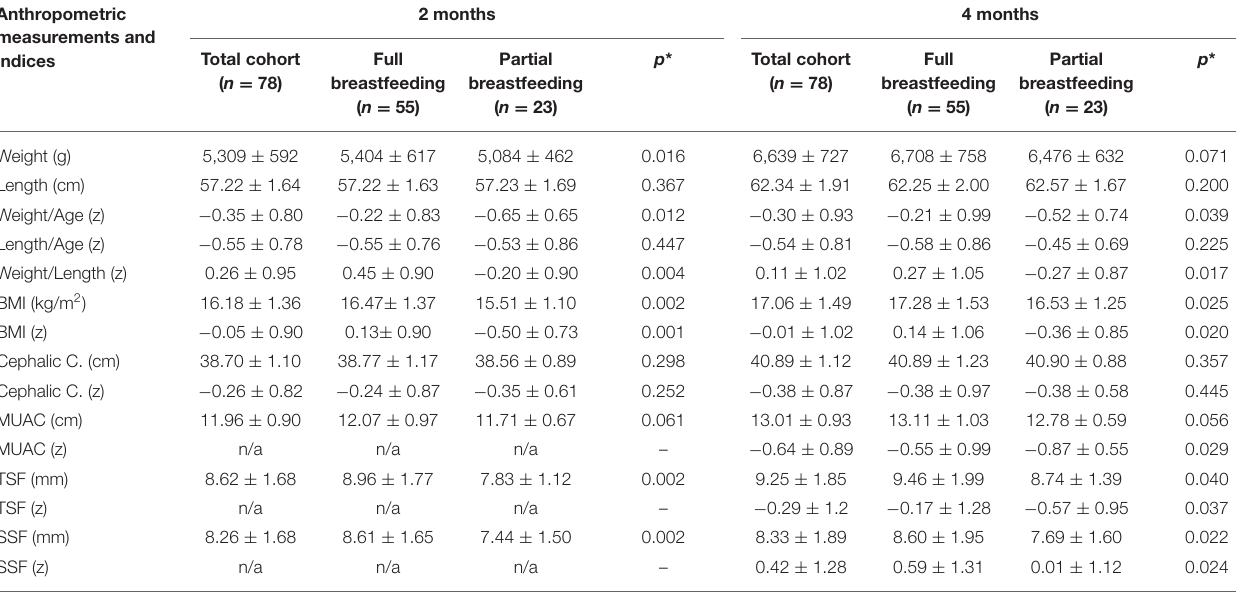
TABLE 1 | Anthropometric measurements and indices (Mean ± SD) of the infants at 2 and 4 months of age according to the type of breastfeeding. Anthropometric measurements